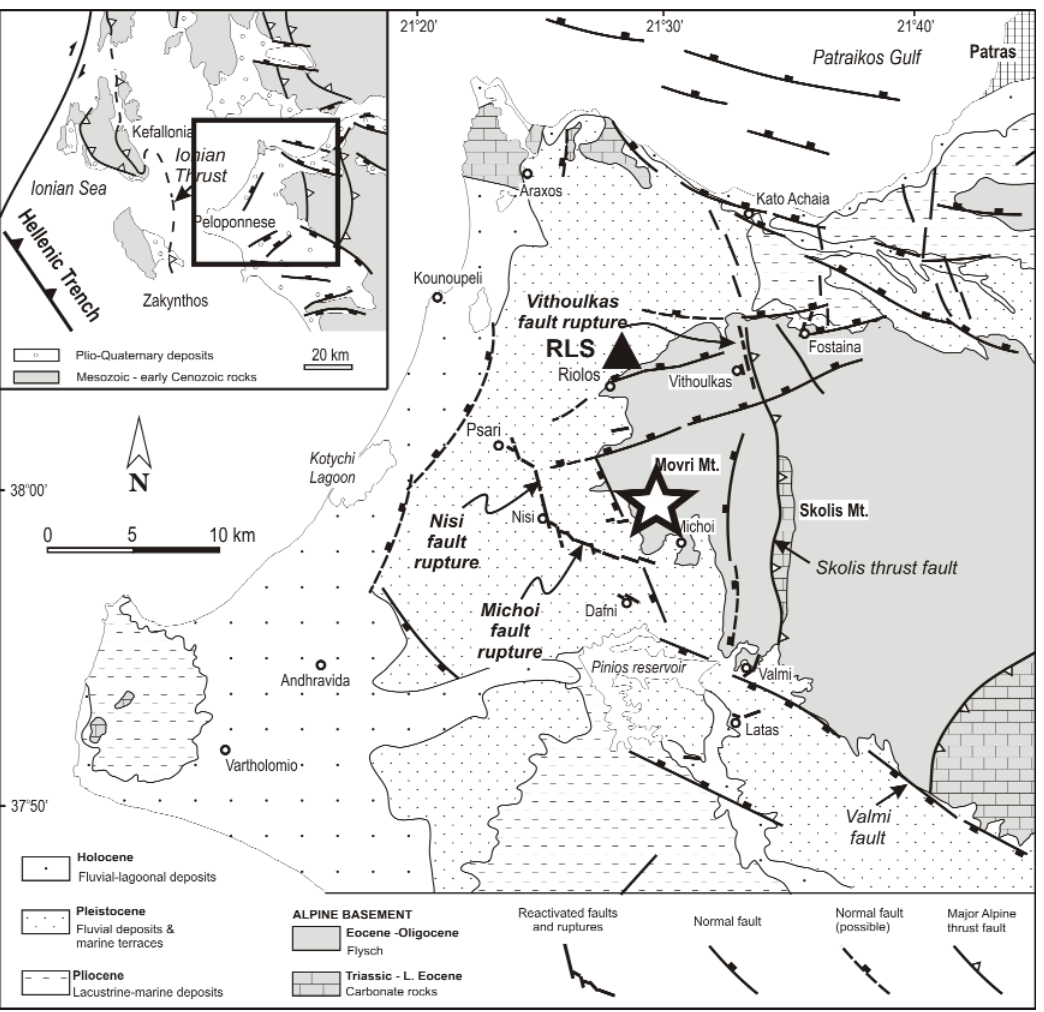
Figure 1. Geological map of northwest Peloponnese showing the active faults, the Movri Mountain earthquake epicenter (star), the Riolos (RLS) station (triangle), and the reactivated faults during the 2008 Movri Mountain earthquake, according to Koukouvelas et al. [2009]. Figure modified from Koukouvelas et al.